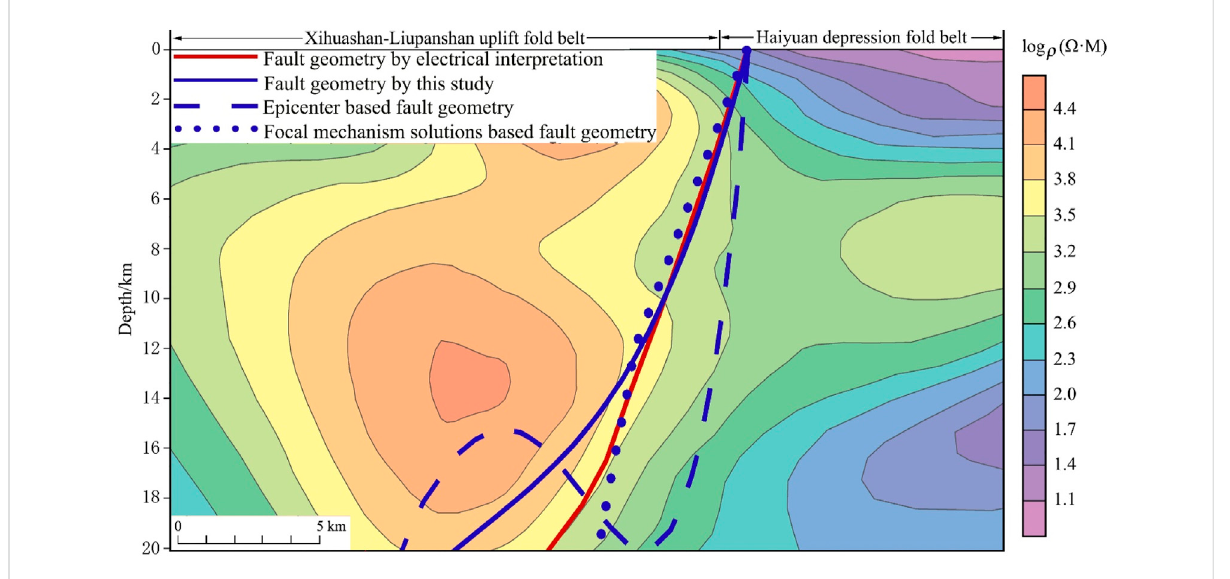
(Figure 3D) of the middle segment of the Yingxiu- Beichuan Fault is obtained based on the fi ne models of fault geometry along the 18 transverse pro fi les (the solid black line in Figure